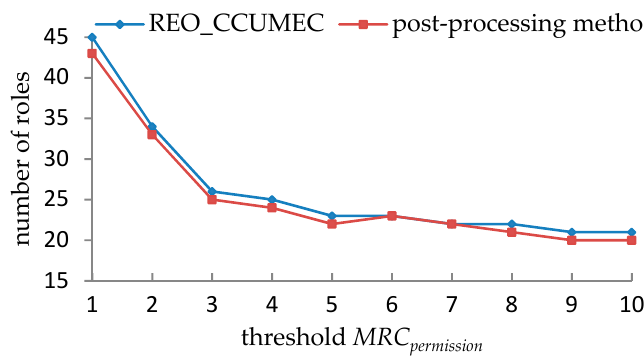
Figure 5. Performance comparison under the PCC in Domino.